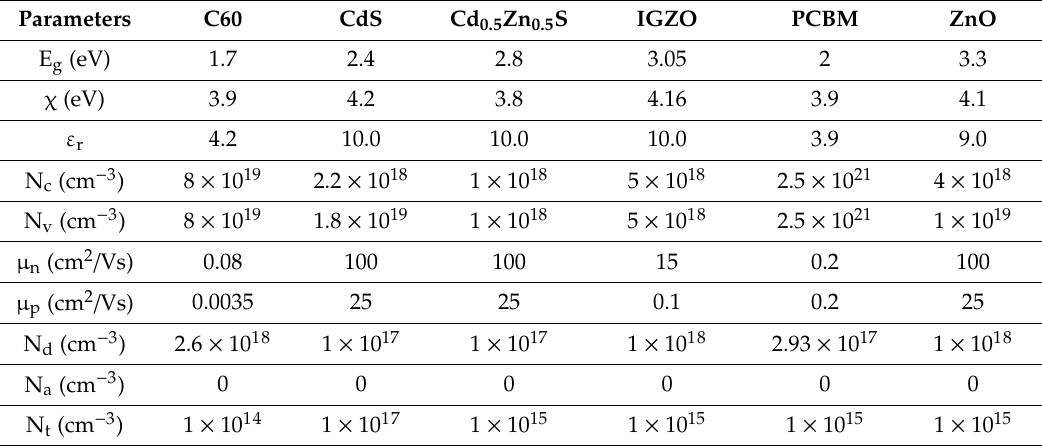
Table 2. Input parameters for di ff erent ETL materials.